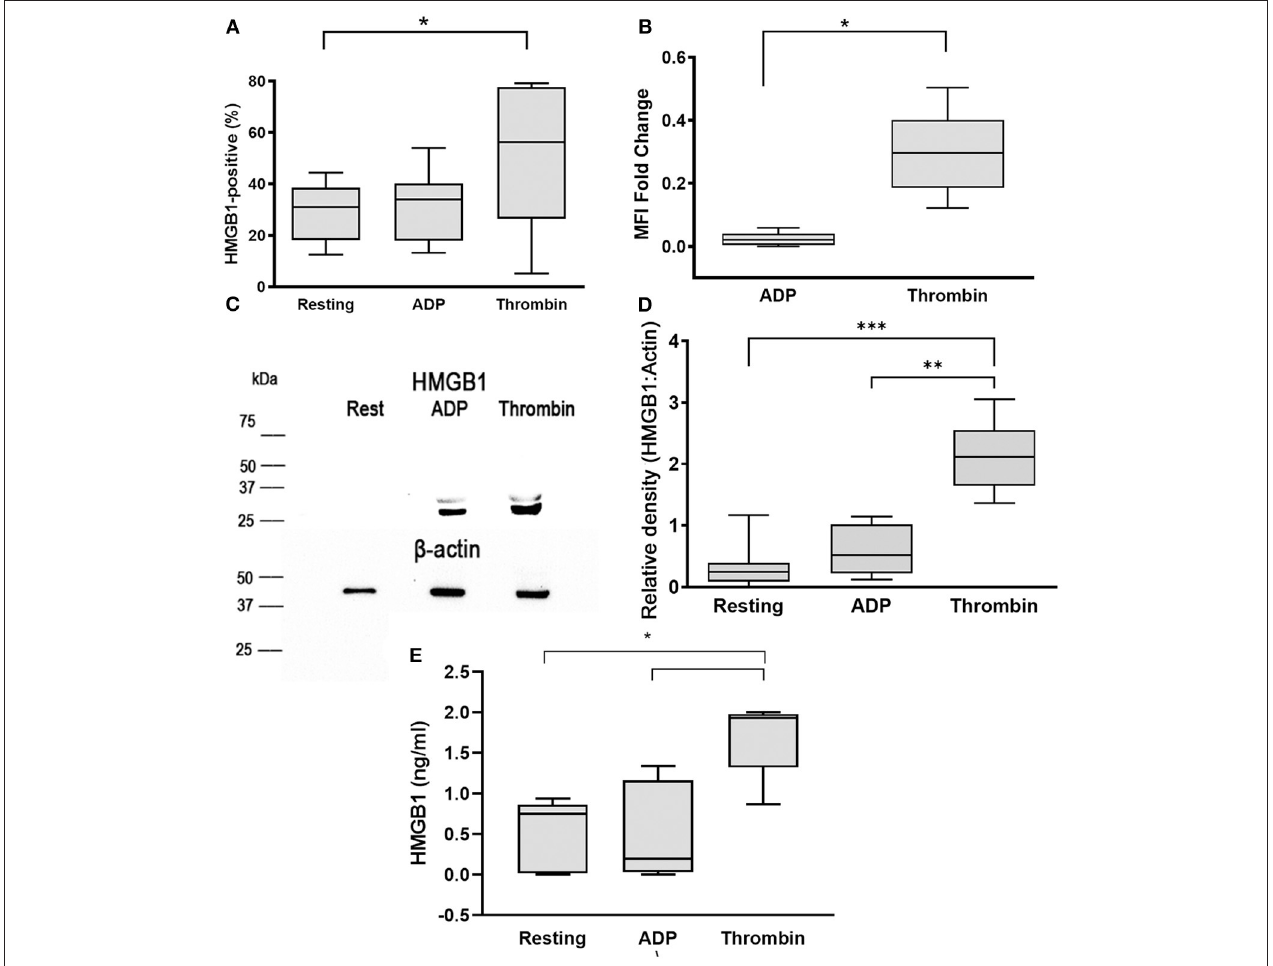
FIGURE 1 | Thrombin upregulates surface and cellular HMGB1 expression in platelets. Canine washed platelets from 8 dogs were either unstimulated (resting) or activated with 10 µ M ADP or 0.01 U/ml thrombin. Surface HMGB1 expression was measured by flow cytometry and expressed as percent (%) of HMGB1-positive platelets or median fluorescence intensity (MFI) fold change on a log 10 scale. (A,B) Thrombin-activated platelets significantly upregulated surface HMGB1 expression compared to resting or ADP-treated platelets. (C) Representative immunoblot of HMGB1 ( ∼ 25–29 kDa) and β -actin ( ∼ 42 kDa) (loading control) in platelet lysate after stimulation with 10 µ M ADP or 0.01 U/ml thrombin (D) . Total cellular HMGB1 expression in 1 × 10 8 platelets/ml was assessed by densitometry of western blots relative to β -actin, used as loading control in resting, ADP- and thrombin-activated platelets in 6 dogs with 2 replicates in each dog with identical results. Thrombin significantly upregulated cellular HMGB1 expression compared to resting and ADP-activated platelets. Regions of the immunoblot were cropped for the individual figure. (E) Platelet supernatant was further analyzed for soluble HMGB1 via ELISA. Each box represents the 25th and 75th quartiles and the line represents the median. Whiskers represent the range of data. * p < 0.05, ** p < 0.001, *** p < 0.0005. Pairwise comparison between ADP- and thrombin-activated platelets was conducted using paired t -test. One-way repeated measures ANOVA was used to assess the effect of platelet activation on HMGB1 expression, followed by post-hoc analysis by Dunnett’s multiple